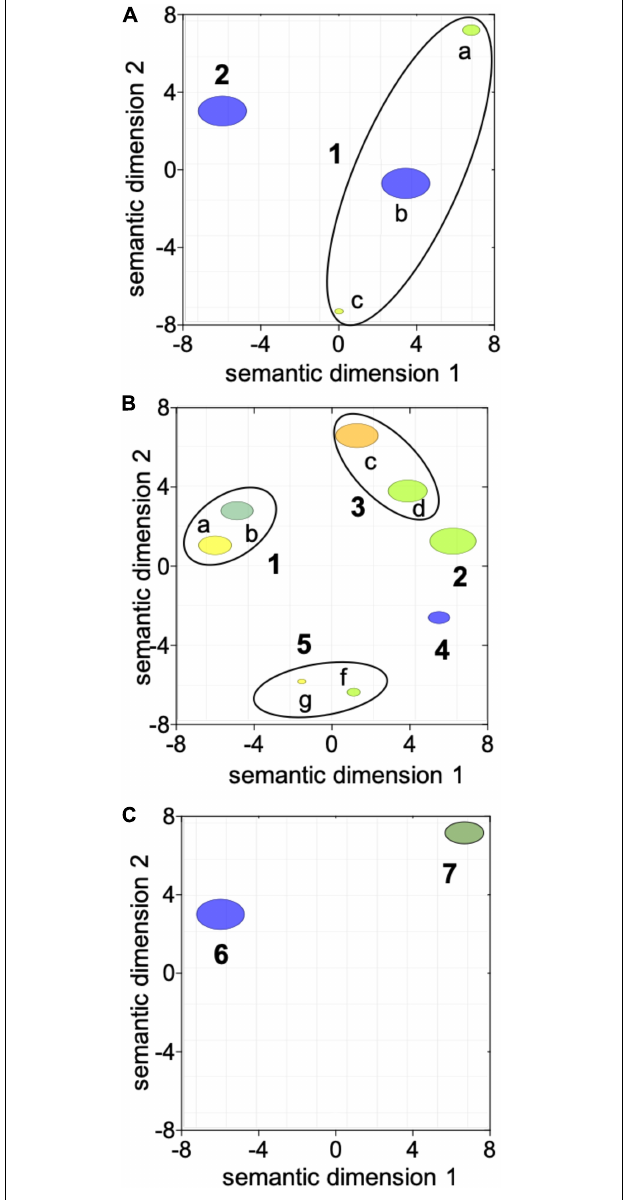
FIGURE 2 | Visualization of the transition in gene expression between adjacent clusters using reviGO semantic analysis of enriched GO terms. ReviGO summarization analysis was performed on the enriched GO terms represented among the DEGs identified between adjacent clusters: (A) “diapause” (CL1) vs. “early to mid-oogenesis” (CL2); (B) “early to mid-oogenesis” (CL2) vs. “pre-spawning” (CL3) and (C) “pre-spawning” (CL3) vs. “spawning” (CL4). DEGs in (A) were identified with using Fisher exact test (FDR; p ≤ 0.05) while for (B,C) , DEGs were identified using a generalized linear model followed by pairwise likelihood ratio tests (FDR; p ≤ 0.05). GO terms with a shared GO parent have been circled (black line). Annotations: